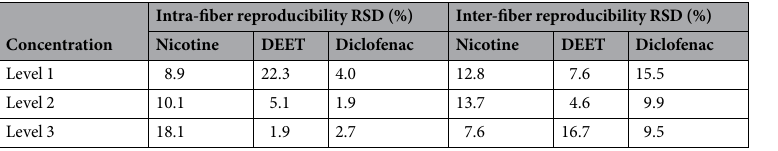
Table 3. Precision of the method in 5% CS. For nicotine and DEET: Level 1: 25 ng mL − 1 , Level 2: 100 ng mL − 1 , Level 3: 1000 ng mL − 1 . For diclofenac: Level 1: 50 ng mL − 1 , Level 2:500 ng mL − 1 , Level 3: 5000 ng mL − 1 .Inter- fiber reproducibility n = 4, intra-fiber reproducibility n = 3; experimental conditions: same as conditions given in the text, desorption volume: 0.1 mL.